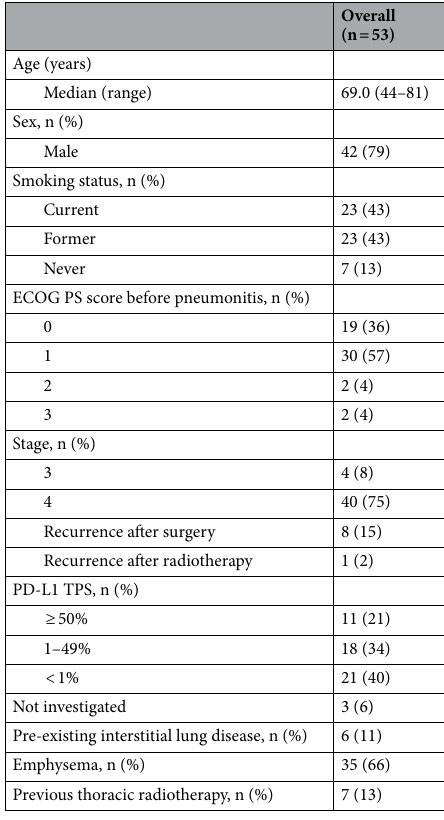
Table 1. Baseline patient characteristics at the diagnosis of pneumonitis. Abbreviations: ECOG PS Eastern Cooperative Oncology Group Performance Status, PD-L1 programmed death ligand 1, TPS tumor proportion